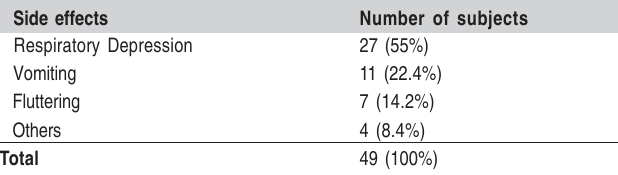
Table 3 - Distribution of side effects in the subjects during dental treatment